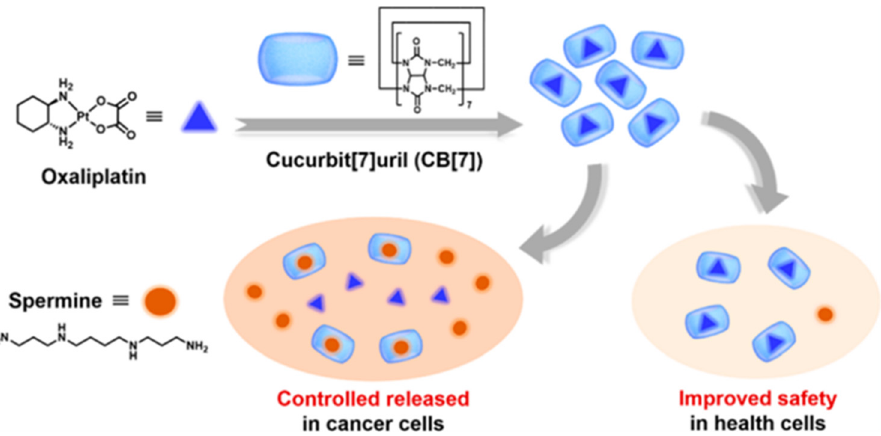
Figure 16. Schematic diagram of oxaliplatin and CB[7] combination and practical application (reproduced with permission of American Chemical Society from ref. [91]).